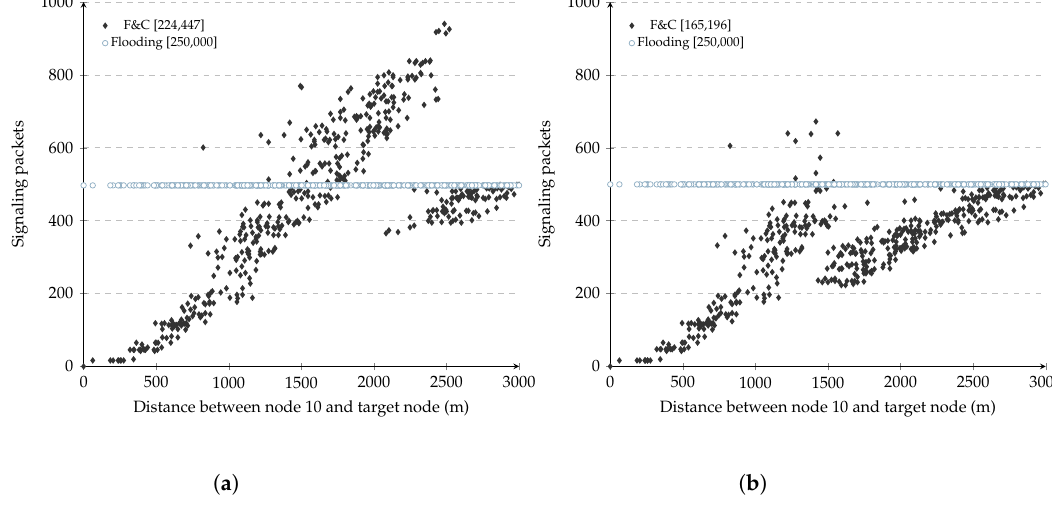
Figure 6. Signaling packets from node 10 to each target node, considering different repeal-flooding boundary (FB) values. ( a ) Flooding Boundary = 11; ( b ) Flooding Boudary = 7.